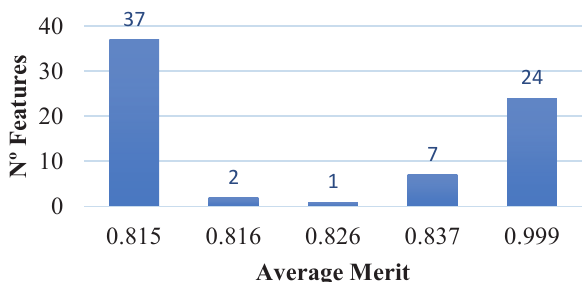
Figure 3: Average merit of information gain attribute selection after used metalearner-chi-squared KLR with 10-fold